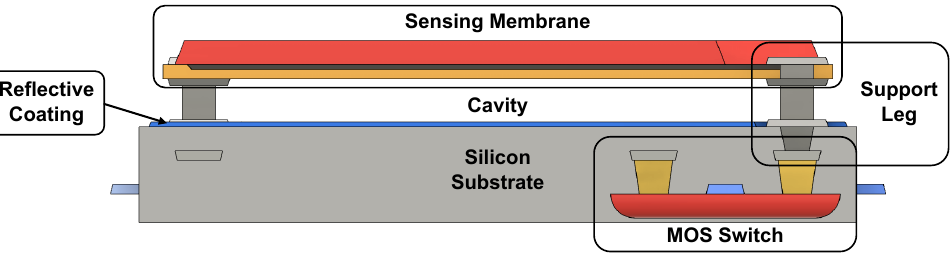
Figure 3. Micro-bolometer